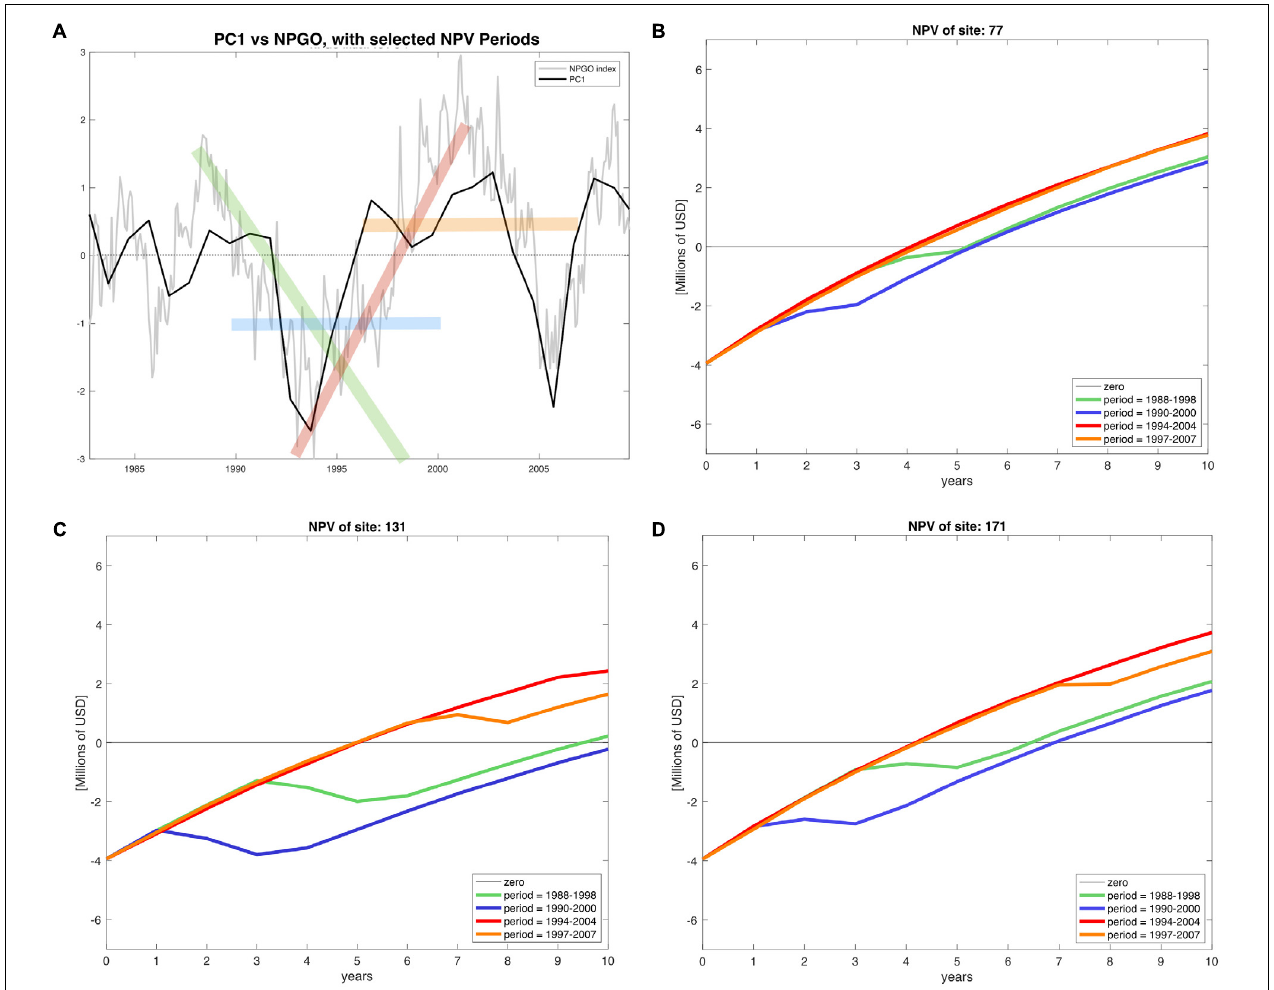
FIGURE 7 | (A) NPGO index (gray) for the period of available environmental data (1981–2008) and PC1 of modeled mussel production (black). The time periods highlighted in green (1988–1998), blue (1990–2000), red (1994–2004), and orange (1997–2007) indicate different phases of the NPGO. (B–D) NPV profiles of the corresponding stages of NPGO for representative sites of the north, center and south of the